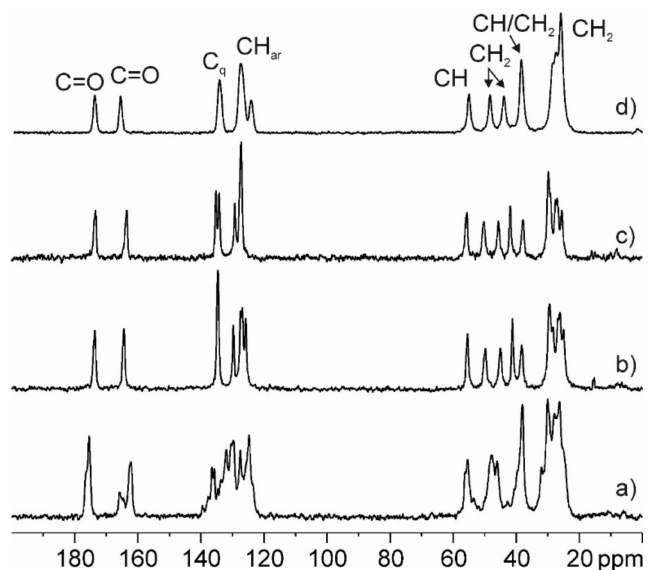
Figure 7. 13 C (150.9 MHz) CPMAS spectrum of PZQ-HH ( d ) recorded at 20 kHz with principal group assignments in comparison with previously reported spectra of commercial PZQ ( a ) Form B ( b ), and Form C ( c ). Table 2. Experimental and calculated chemical shift for 13 C SS-NMR analyses of PZQ-HH, compared to Form A, Form B and Form C, from refs. [19,20]. Atoms numbering refers to Figure